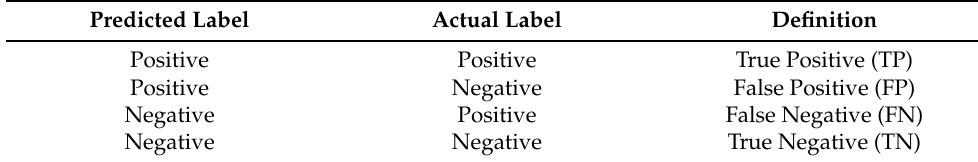
Table 3. Definition of the terms used in